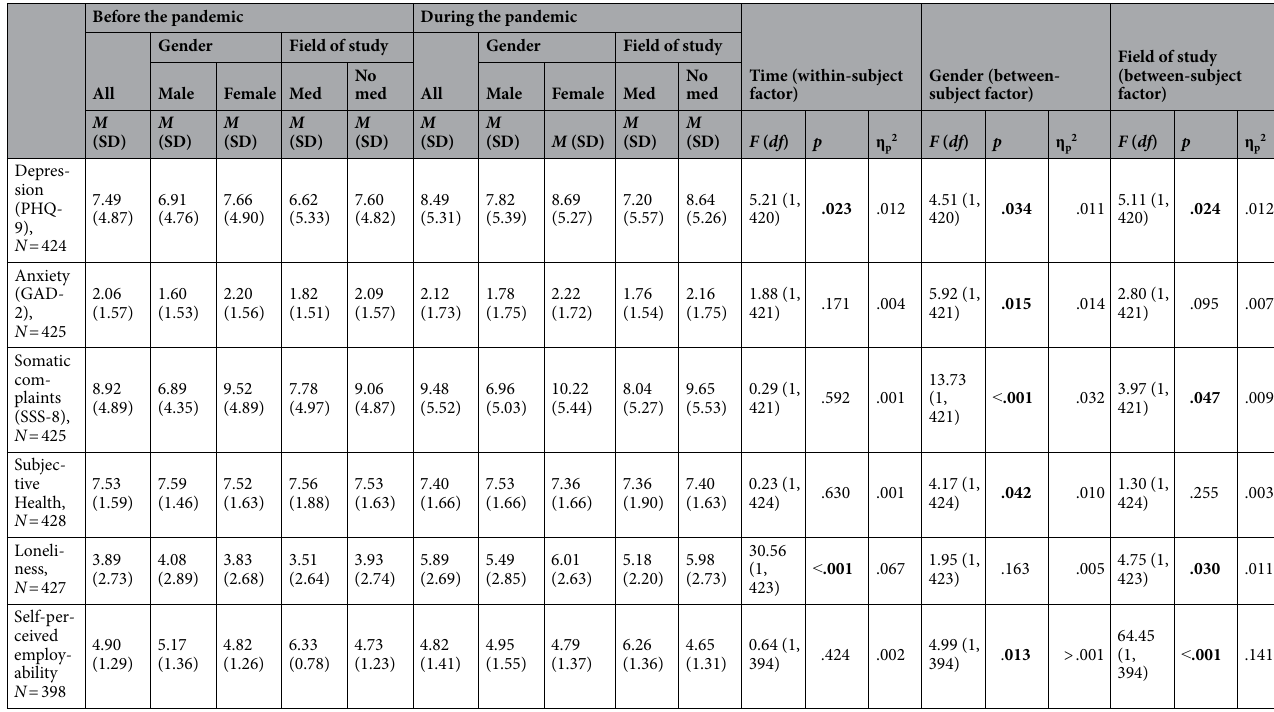
Table 2. Means, standard deviations, and analyses of variance in depression, general anxiety, somatic symptoms, loneliness, self-perceived employability, and subjective health by time of survey (pre-pandemic vs. during the pandemic), gender (male vs. female), and field of study (medical vs. other). Med Medical students, No med Non-medical students, PHQ-9 Patient health questionnaire-9, GAD-2 Generalized anxiety disorder-2, SSS-8 Somatic symptoms scale-8. Different N due to list-wise